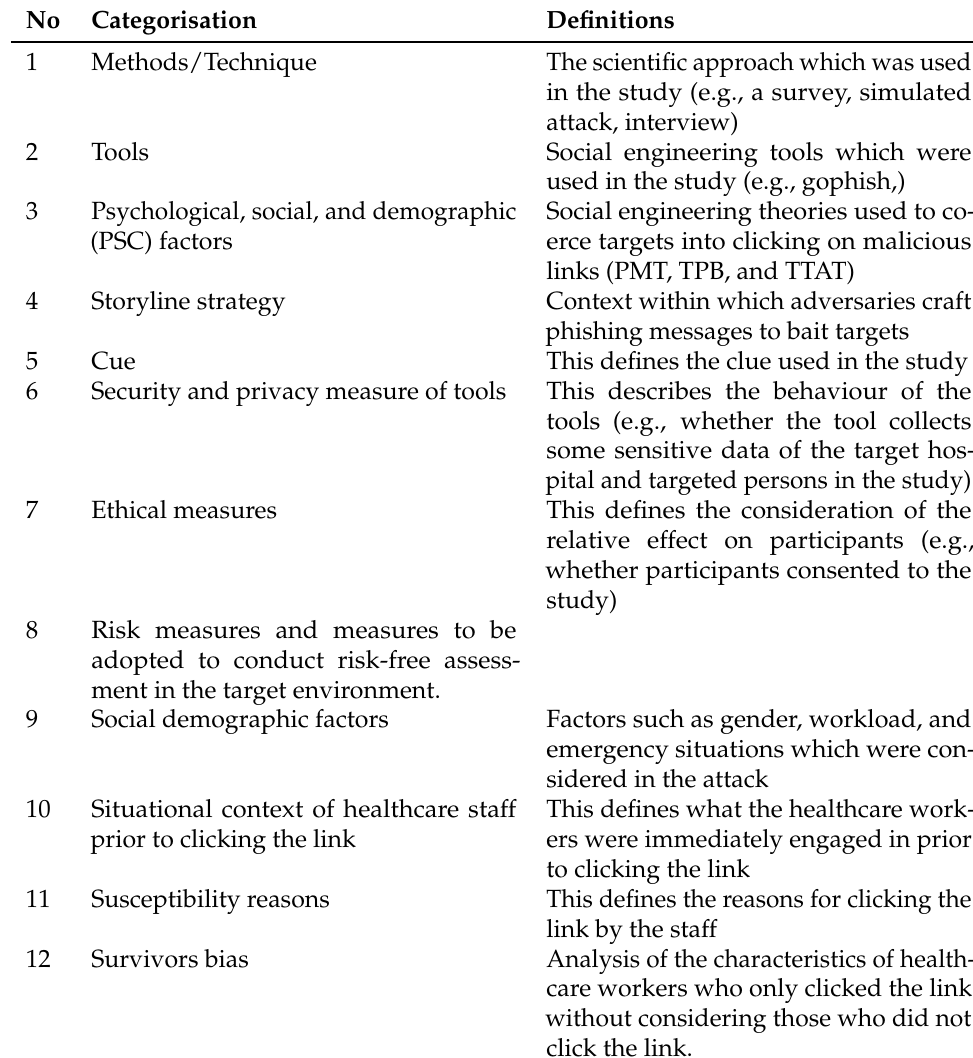
Table 1. Data categorization and